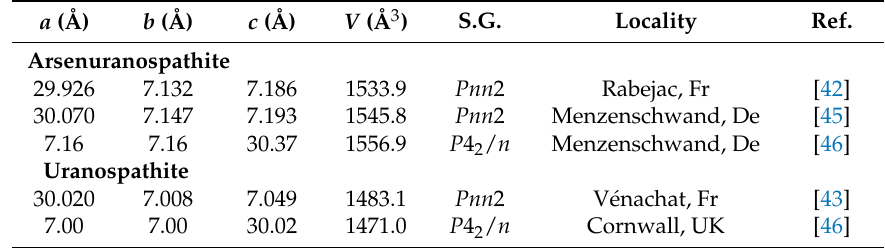
Table 10. Comparison of the crystallographic parameters of arsenuranospathite and